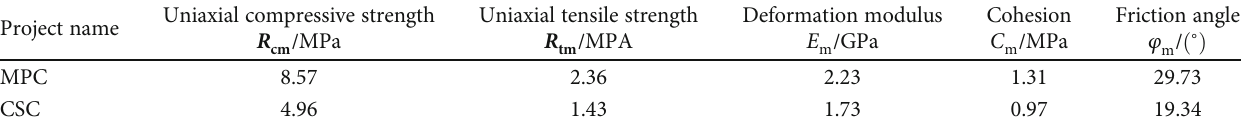
Figure 8: Combined grouting anchor cable support and parameters. Table 6: Prediction results of chamber rock mass parameters (project type: chamber; H = 960